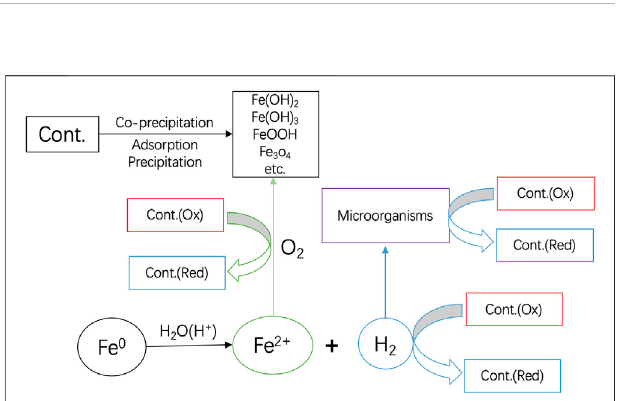
FIGURE1| PathwaysofcontaminantremovalandtransformationsinFe 0 / H 2 O systems: Onlywater has accessto the Fe 0 surface. Fe 2+ and H 2 are stand alone reducing agents. O 2 is reduced by Fe 2+ . H 2 can be used by microorganisms to induce redox transformations of dissolved species. Upon oxidation of Fe 2+ , various solid iron hydroxides/oxides precipitate and act as contaminant scavengers. Reproduced with permission from Elsevier, the